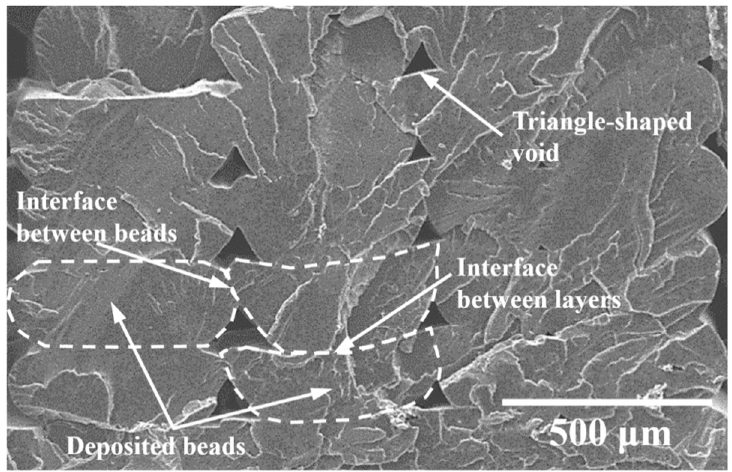
Figure 5. SEM image of the voids formed during the printing process of